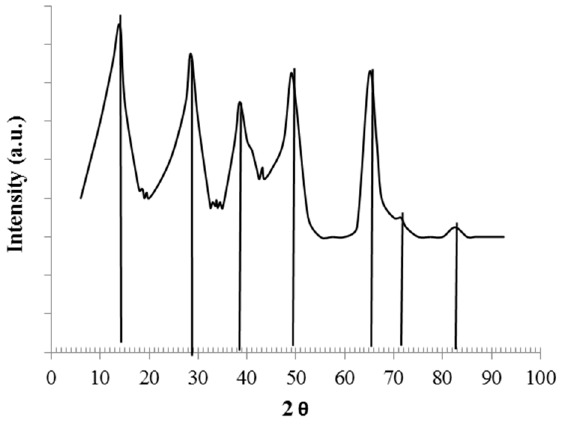
Figure 1. XRD of pseudoboehmite.